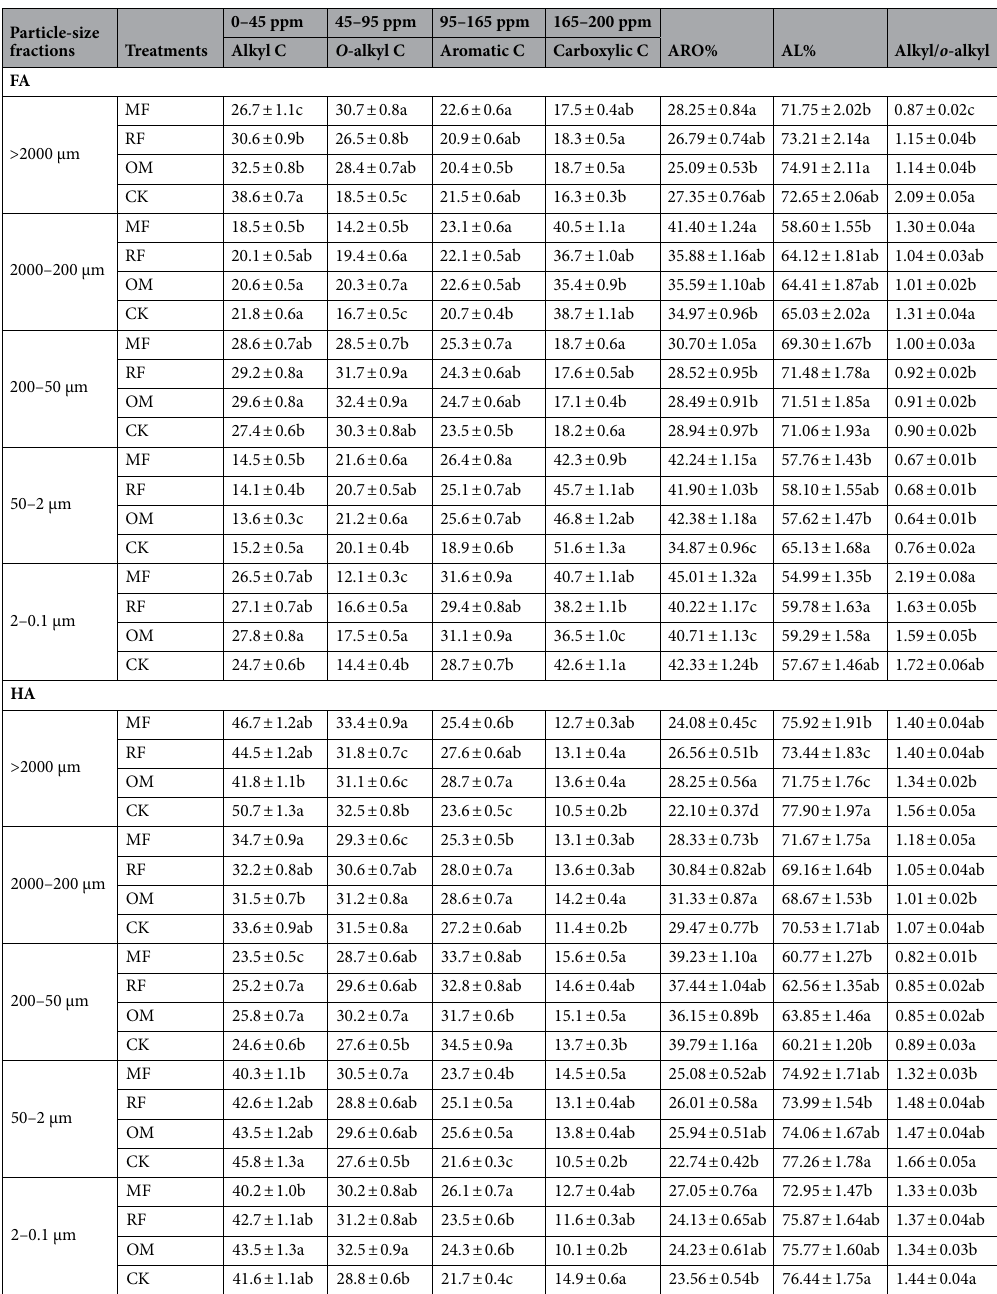
Table 2. Contribution of the different humus C type, aromaticity (ARO%), alphaticity (AL%) and alkyl/ o - alkyl ratio were determined by using CPMAS 13 C NMR of FA and HA in soil particle-size fractions under different fertilizer treatments. Values followed by different lowercase letters within a column were indicated significant difference at p < 0.05. MF chemical fertilizer alone, RF rice straw and chemical fertilizer, OM 30% organic manure and 70% chemical fertilizer, CK without fertilizer input as a